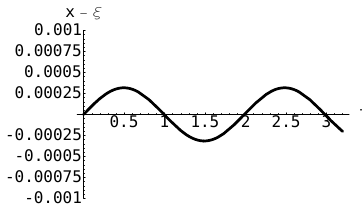
Figure 3. Difference between neigh- boring solution and trivial solution of